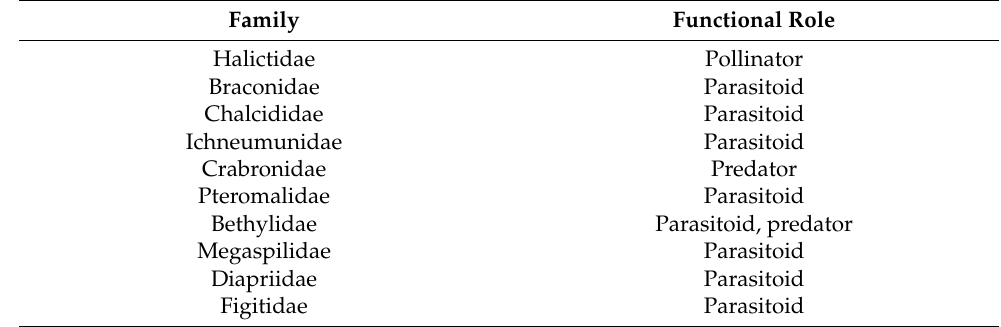
Table 5. Families of Hymenoptera collected in yellow bowl pan traps in the province of Chimborazo. The families are ordered in relation to abundance (from highest to